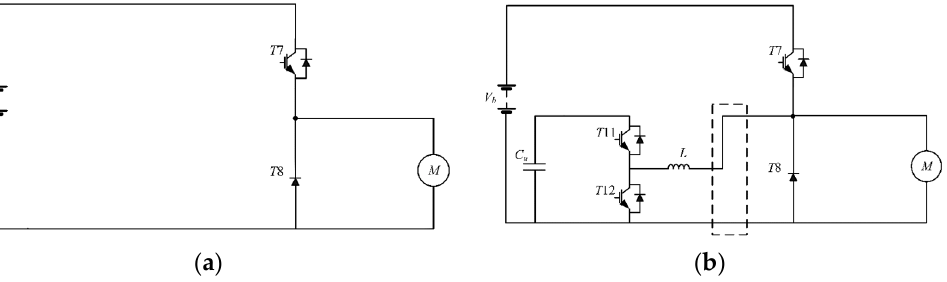
Figure 8. The drive mode of the HES. ( a ) Single-ba tt ery mode. ( b ) The ba tt ery and the SC